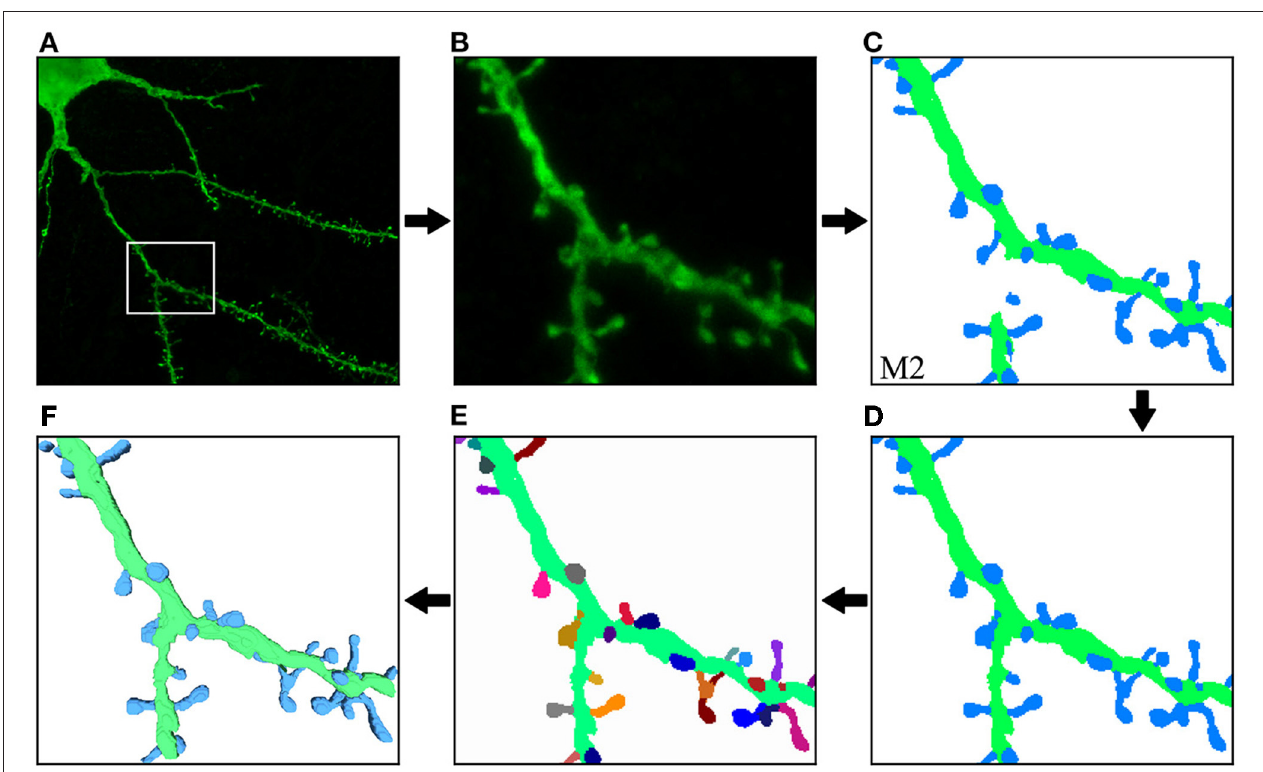
FIGURE 10 | First case study: (A) original confocal image; (B) ROI selected by the user; (C) M2 segmentation; (D) correction of misclassified and unconnected components; (E) the segmentation after the separation of overlapping spines. Finally, dendritic shaft and spine surfaces are calculated (F) . The top row shows the process steps from left to right, and the bottom row continues from right to left. This order allows direct comparison between the preceding and successive images at each